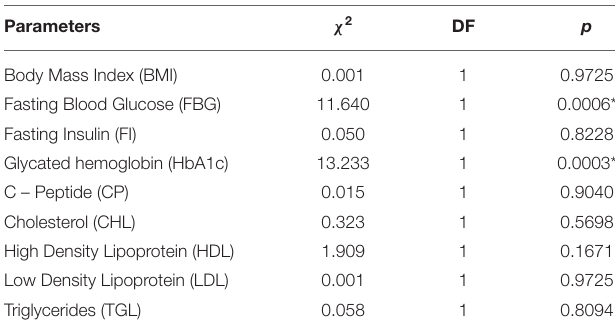
TABLE 1 | Differences in physiological parameters between diabetes subjects and controls assess by Kruskal–Wallis rank–sum test.